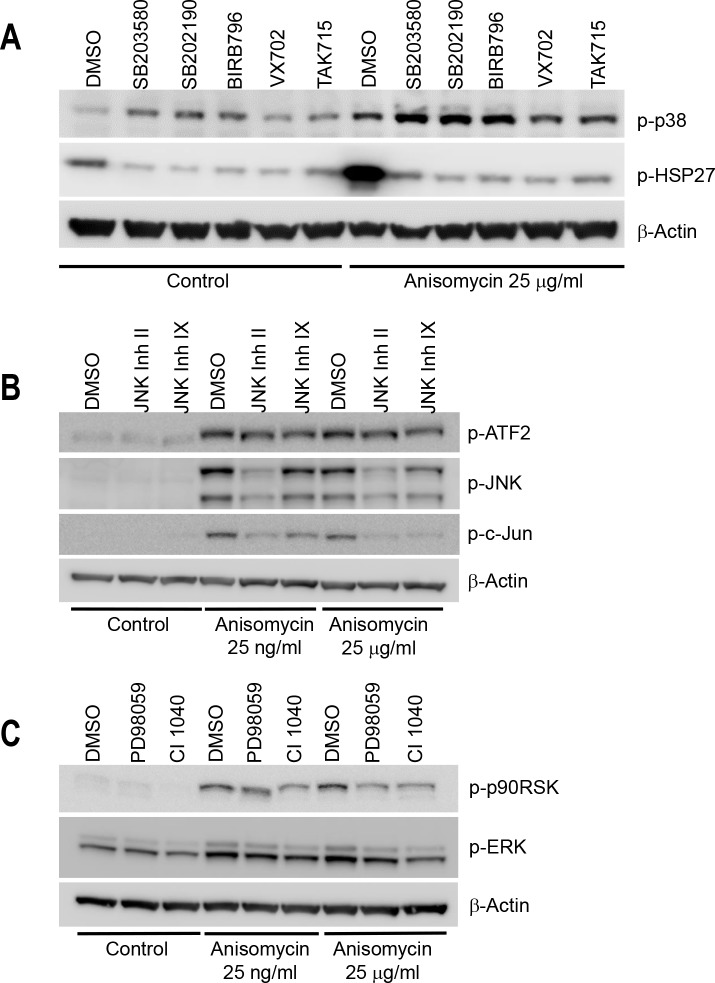
Western-blot of cell lysates from conditions shown in Figure 2C confirms the chemical inhibitors are efficient towards inhibiting corresponding MAPKs pathway.Cells were treated with indicated inhibitors for 24 hr before collecting lysates. Anisomycin was added to select wells 1 hr prior to making lysates, to activate MAPK pathways. All inhibitors were used at the ‘high dose’ indicated in Figure 2C and Figure 2—figure supplement 2. (A) Cells treated with p38 inhibitors display a lower level of p-HSP27 (downstream of p38). The p38 inhibitors induce a higher level of p-p38. This is due to negative feedback in the p-p38 pathway, and the fact that p38 inhibitors prevent p-p38 from phosphorylating downstream substrates, but do not block phosphorylation of p38 itself by upstream regulators. (B, C) Cells treated with JNK or MEK I/II inhibitor inactivate the corresponding pathway under Anisomycin induction. The influence of the inhibitor is not obvious under control condition probably due to low basal activation of the pathways.